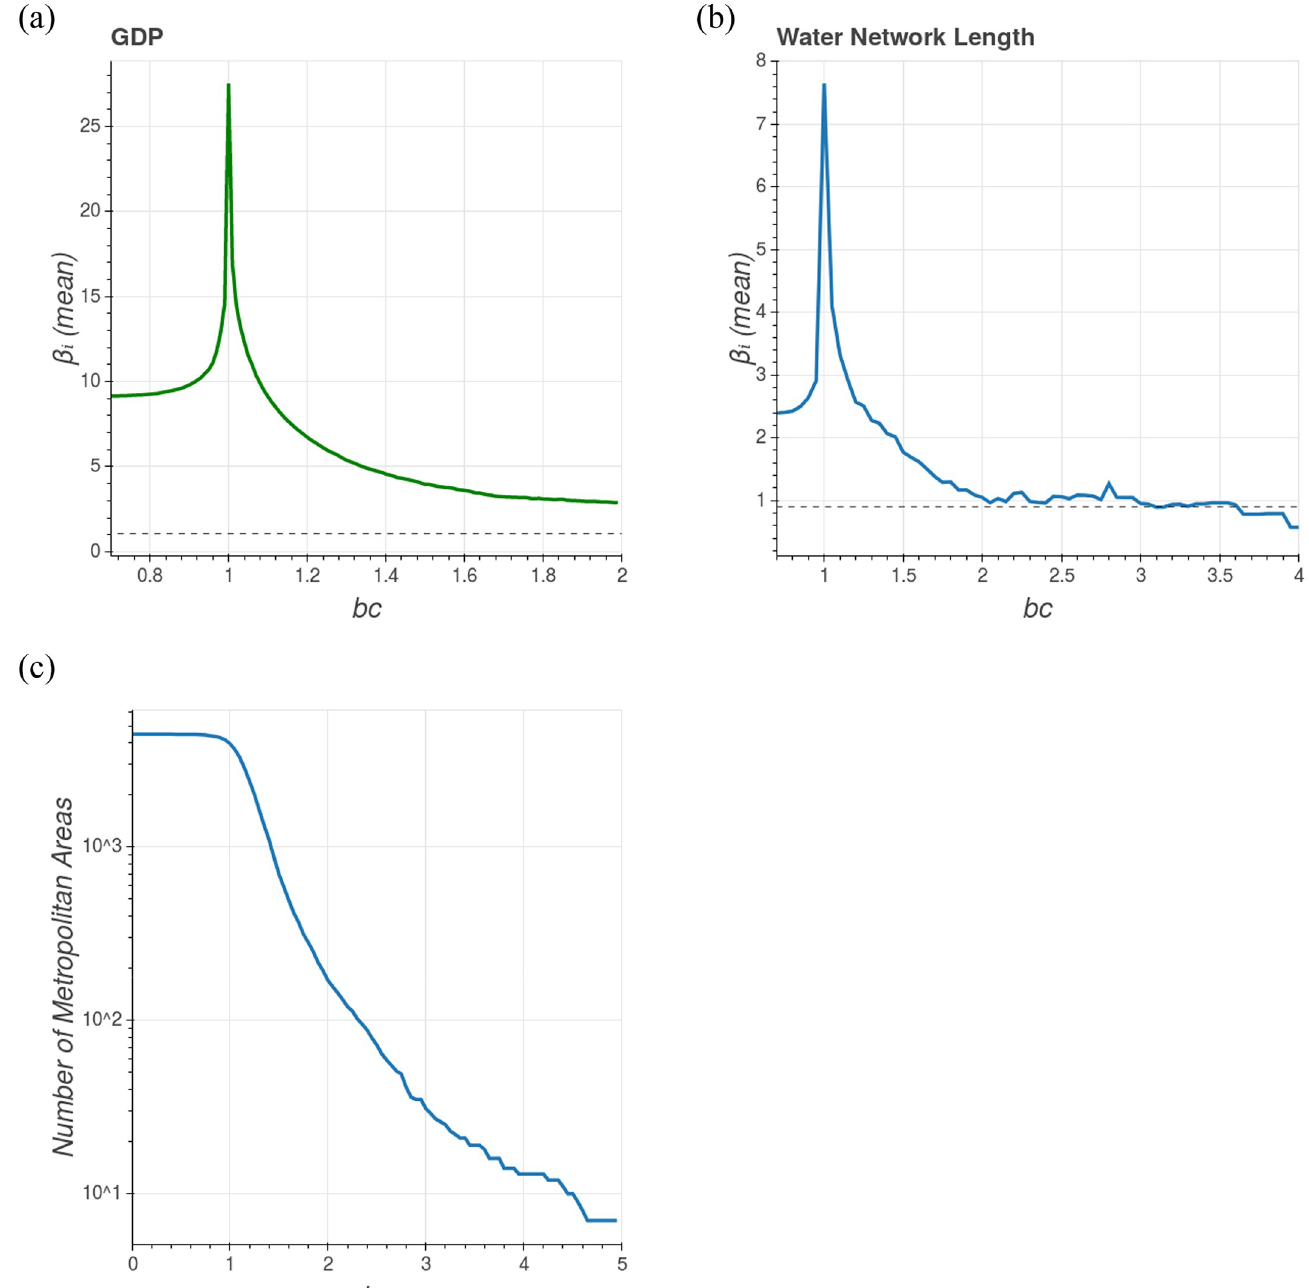
Fig 7. Mean value of the longitudinal scaling exponent as a function of the growth rate threshold b c . For GDP (plot A) and water network length (plot B). The parameter b delimits the cities that will be used to compute the average. The mean value of � b c more � b approaches to β T (represented by the dashed line). It’s reasonable to think that in an ideal situation with no external forces and with a significant number i of cities with the larger growth rate for better statistics, the average of the longitudinal scaling exponent will converge to the value of the transversal scaling exponent. Plot C: number of metropolitan areas used to compute the mean as a function of b c . This number is drastically smaller for greater b c values.